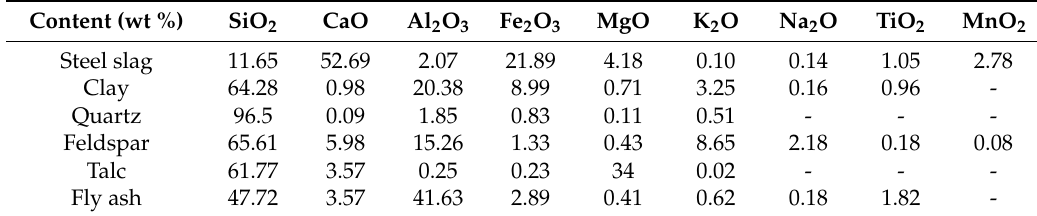
Table 1. Main chemical compositions of the raw